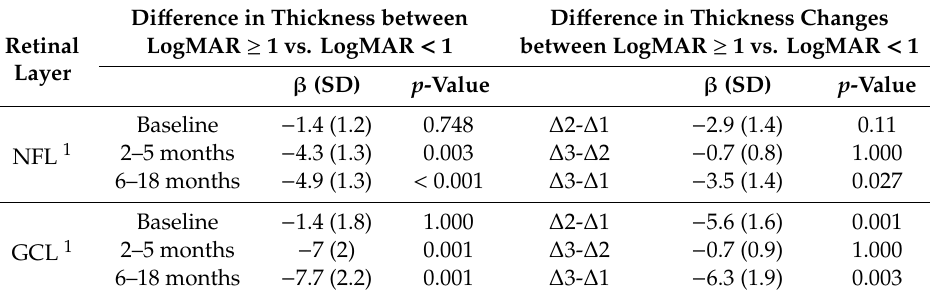
Table 4. E ff ect of initial visual acuity on the change in thickness of each